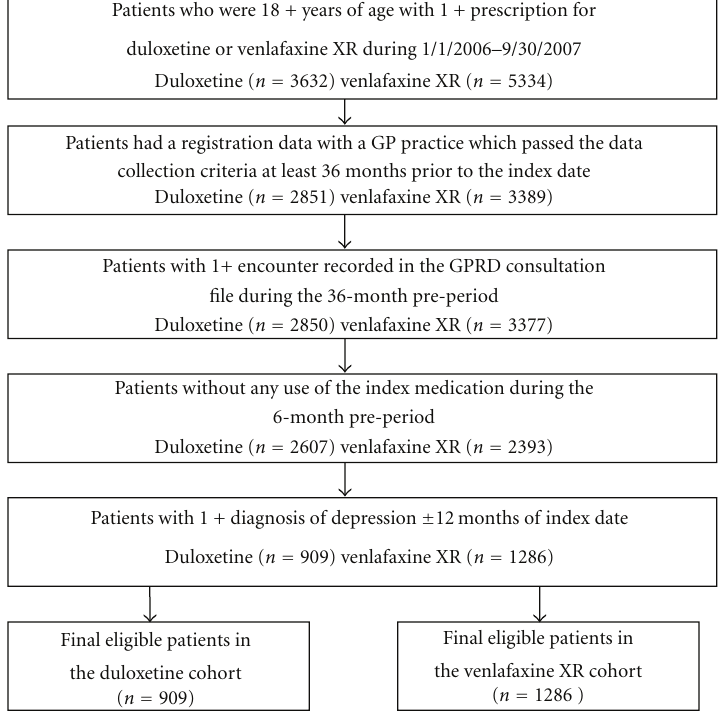
Figure 1: Patient